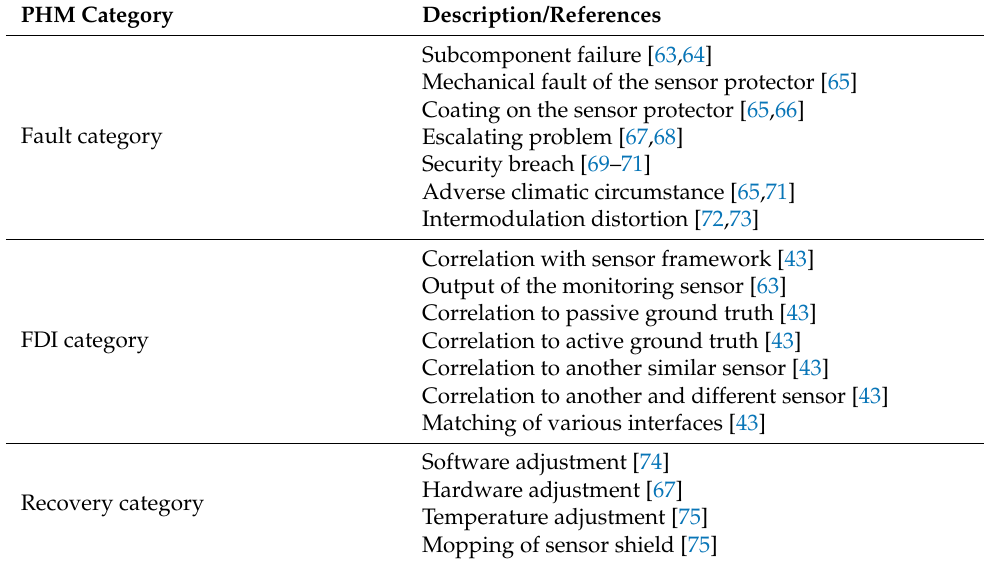
Table 4. Details of light detection and ranging (LiDAR) prognostic health management (PHM).